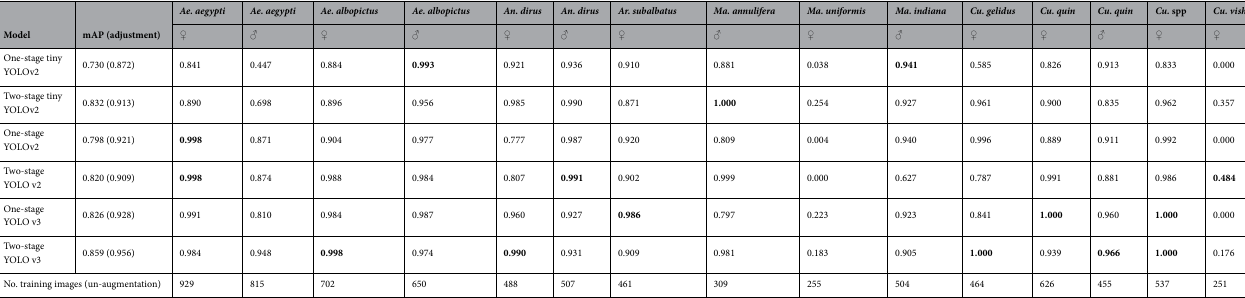
Table 4. Comparison of detection results using different versions of one-stage and two-stage YOLO models. The mAP represents the mean average precision. The mAP_adj represents the adjusted mAP which was calculated without the precise values of Ma. uniformis and Cu. vishinui. The adjusted values were used to avoid bias, which may reduce the mAP. Cu. quin represents Culex quinquefasciatus. Bold value represents the highest value of the proposed statistical parameters by model.